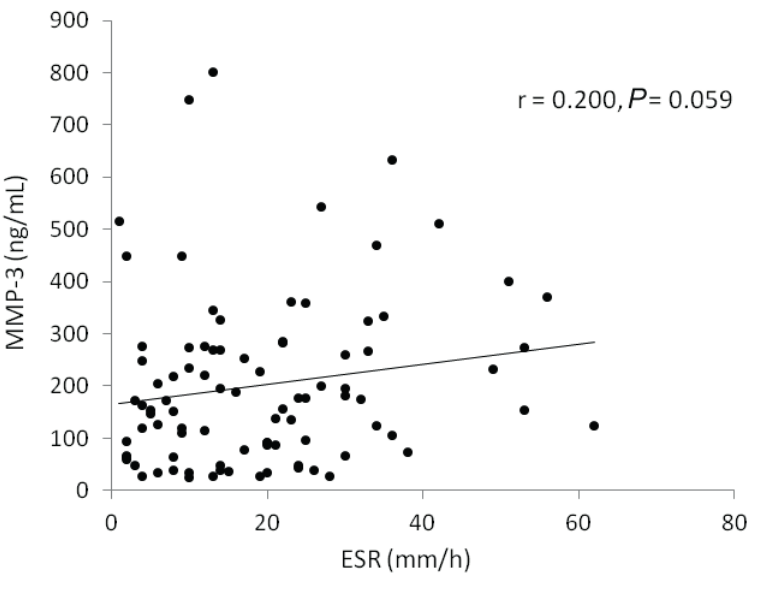
Fig. 5. Correlation between MMP-3 and ESR.